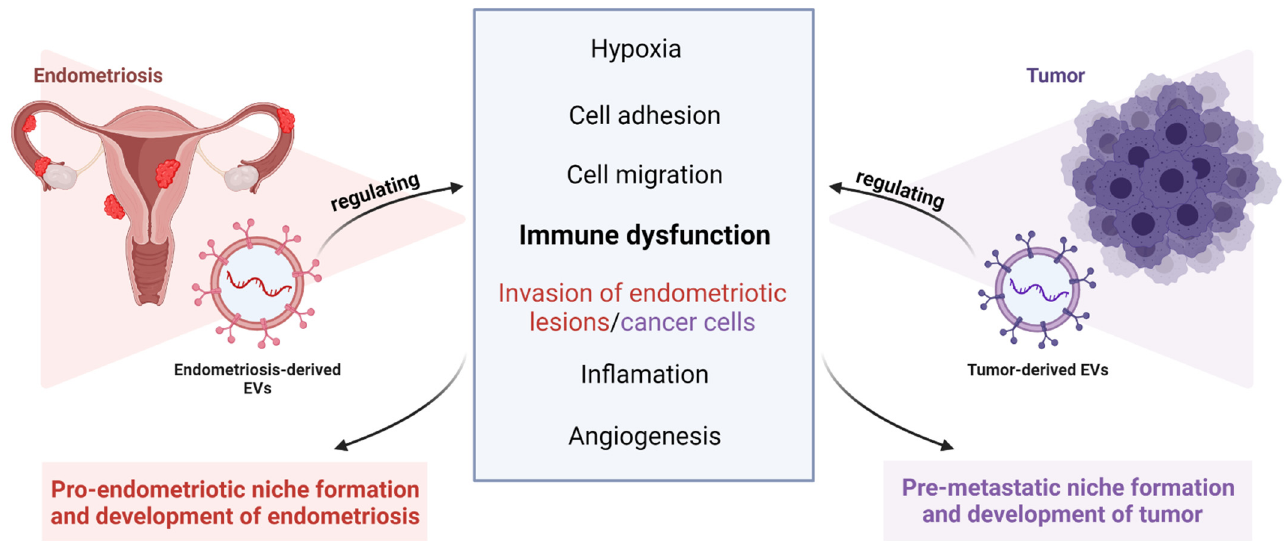
Figure 1. Extracellular vesicles (EVs) derived from diverse microenvironments of endometriosis and gynecologic tract malignancies mediate similar disease progression mechanisms [10]. In this review, we focus exclusively on EV-mediated immune suppression activities. This image was created using BioRender (http://biorender.com/ accessed on 22 April 2022).